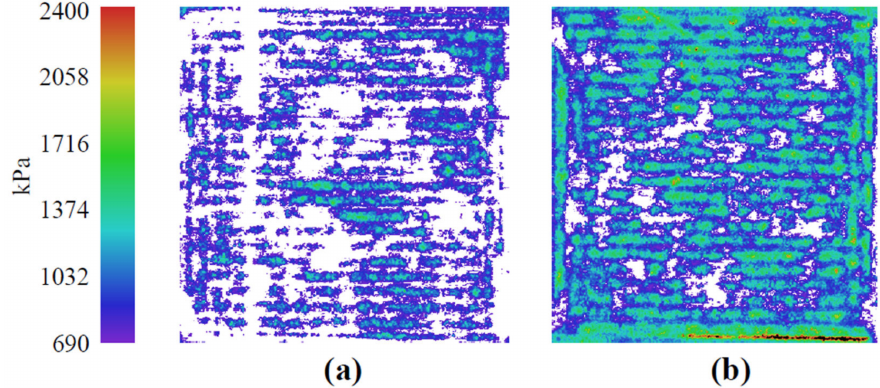
Figure 3. Compression paper for contact intensity and uniformity between the 16 cm 2 flow fields ( a ) quasi-adiabatic fixture and ( b ) standard fixture. Each fixture was torqued to 70 in · lbs.